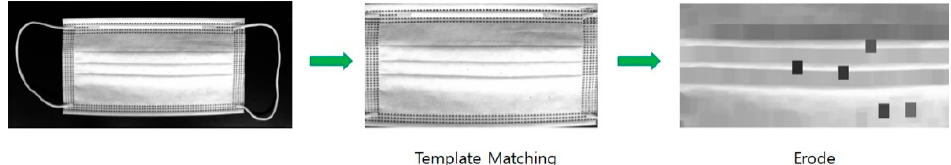
Figure 9. Preprocessing in dotted defect detection. ( a ) Apply template matching to mask image; ( b ) apply morphology erode calculation to ( a ) image.